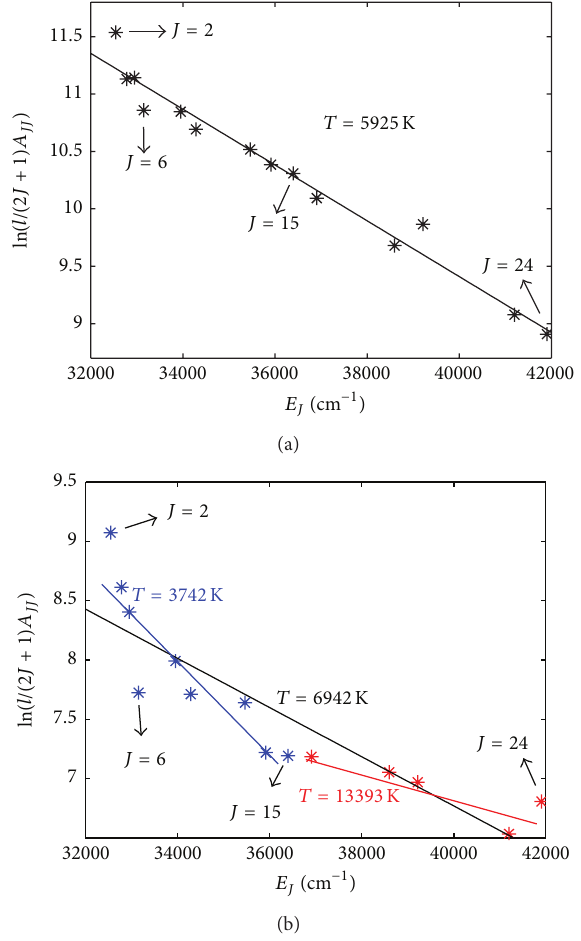
Figure 6: Typical Boltzmann plots in the jet axis (a) and in the jet periphery (b). Points correspond to lines marked in Figure 3 by rotational quantum numbers J ; here, some 𝐽 values are also